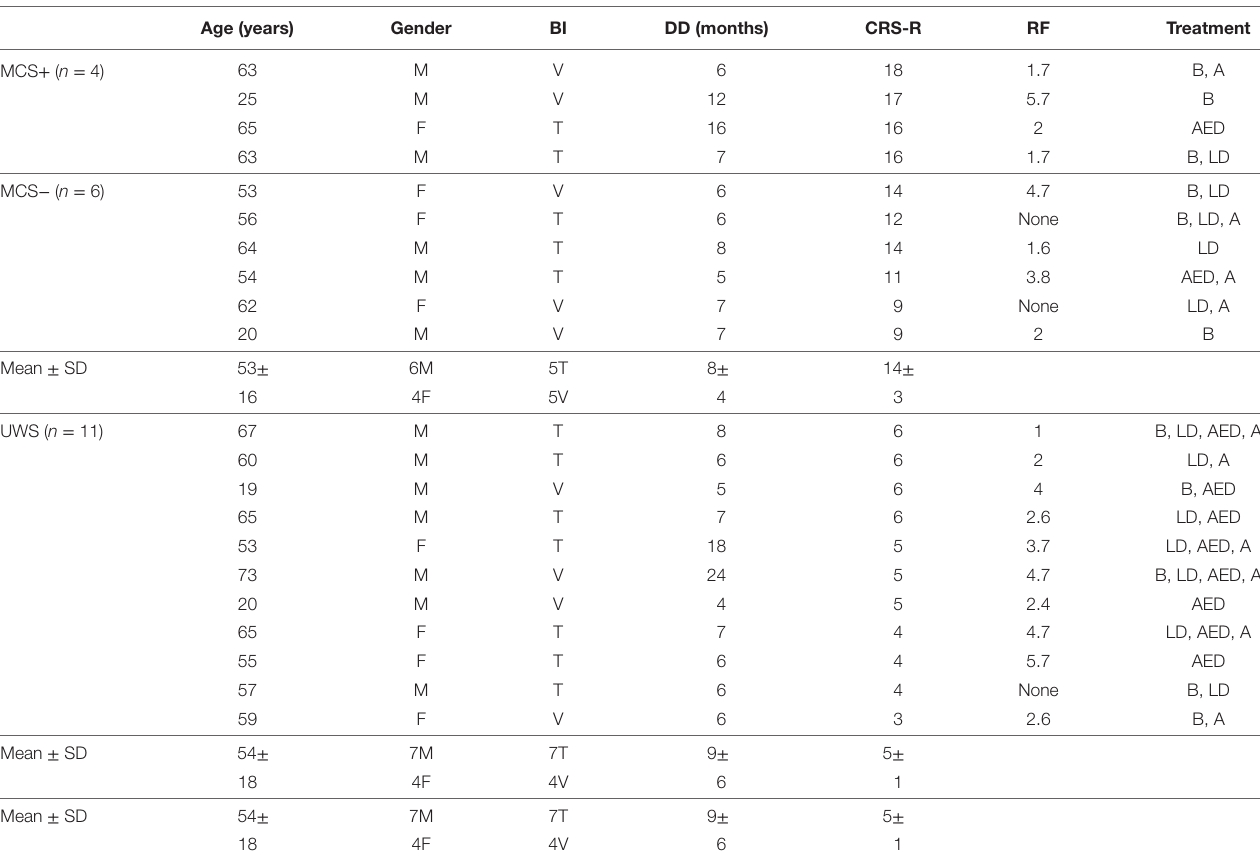
Table 1 | Clinical–demographic